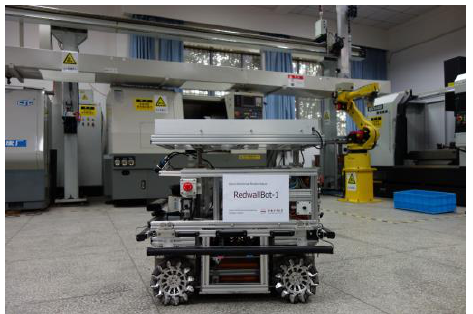
Figure 1. Omni-directional mobile robot RedwallBot-1.